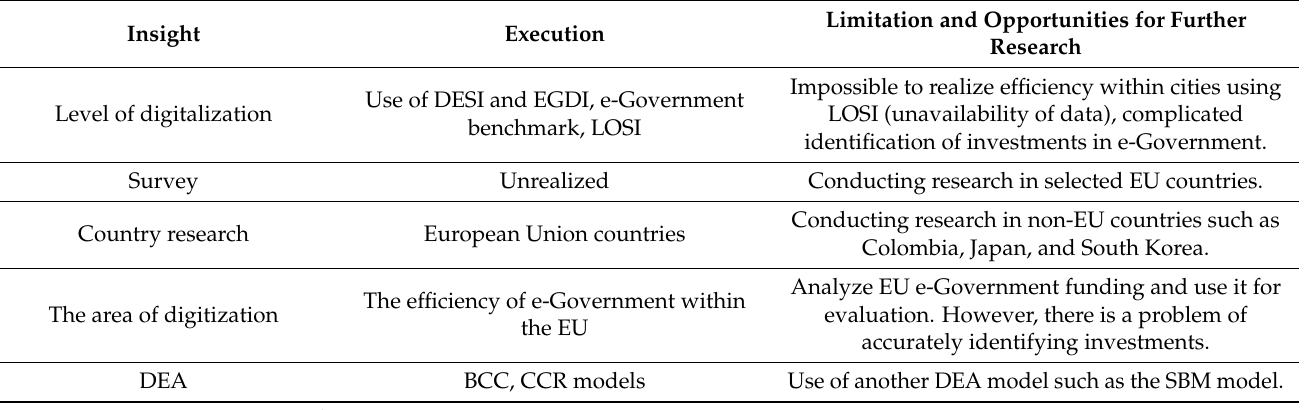
Table 14. Insights from this study and the